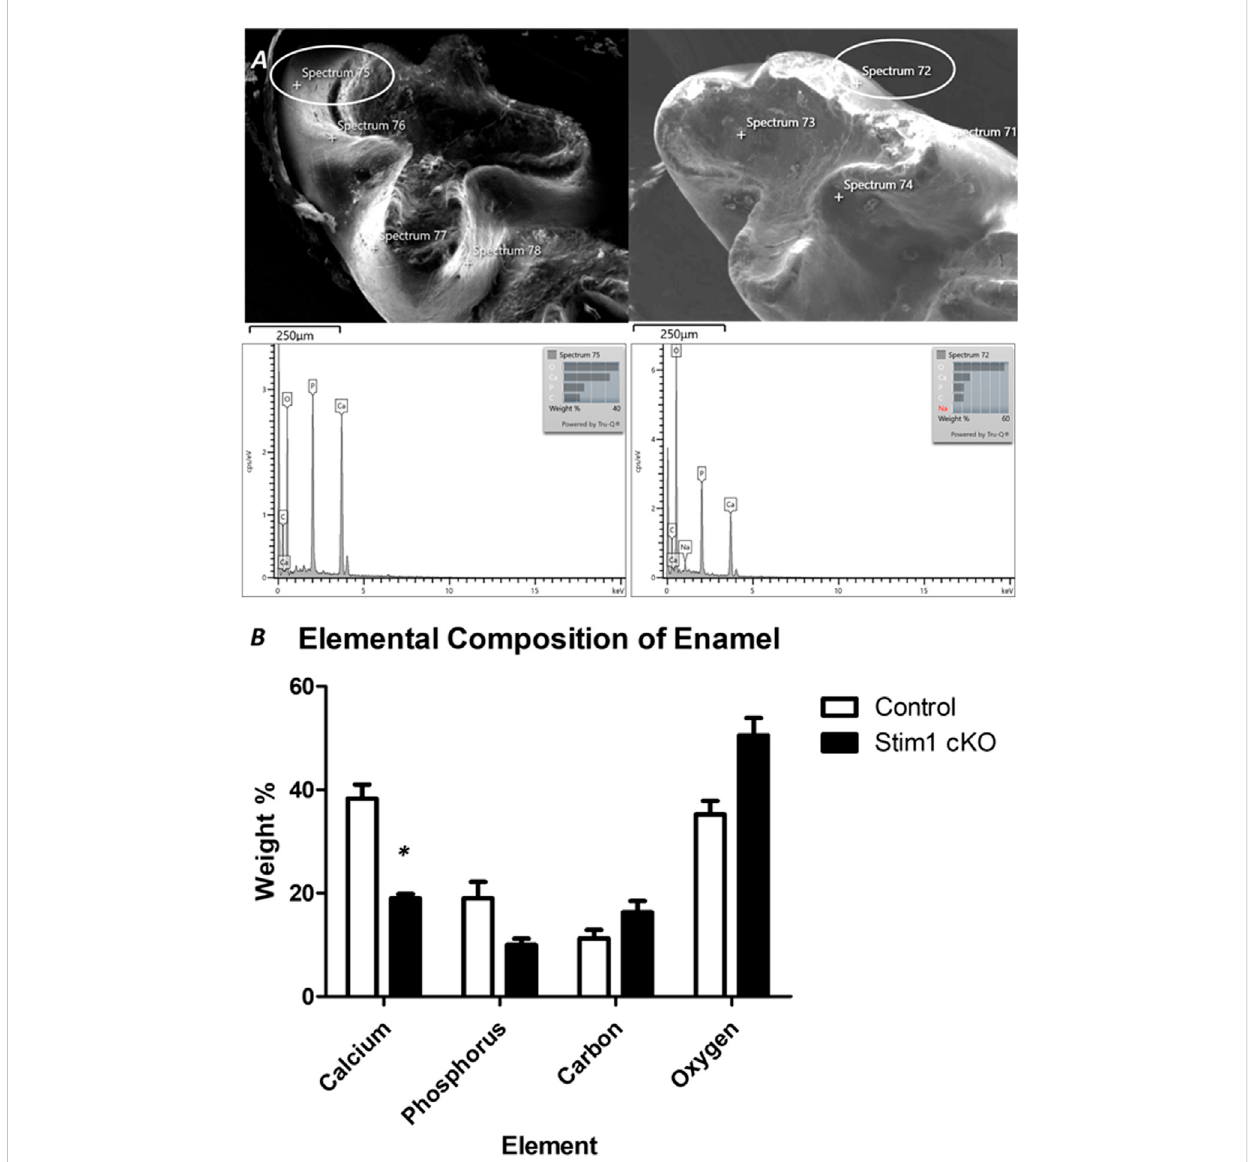
FIGURE 5 Elemental composition analysis of enamel. (A) To assess enamel mineralization, we analyzed changes in elemental composition in enamel using energy dispersive x-ray spectroscopy (EDS). For EDS, 4 beams were generated on the cusp slopes of maxillary fi rst molars that received no processing of the enamel surface in order not to alter its composition. The lower row shows the peaks generated from the circled areas. (B) Quantitative analysis of representative average measurements taken by EDS of elemental composition of the enamel of control and Stim1 cKO enamel. Results show that the enamel of Stim1 cKO mice is Ca de fi cient, with a very signi fi cant loss of the Ca amount found in controls (Figure 5B). Other key elements present in mineralized enamel, such as phosphate (P), were also lower in Stim1 cKO mice compare to controls albeit non-signi fi cantly. (mean ± SEM of n = 3 mice per group; * p <